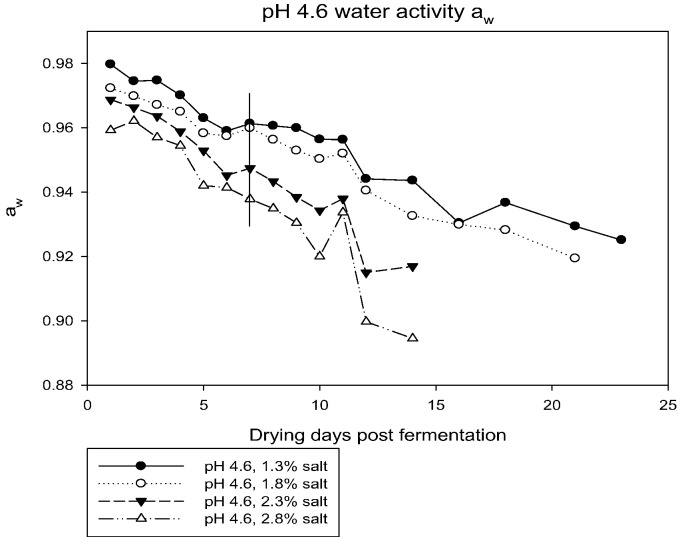
Time in days until sausage chubs reached endpoint aw of 0.92.Vertical line indicates last day upon which infective larvae were found in mice.